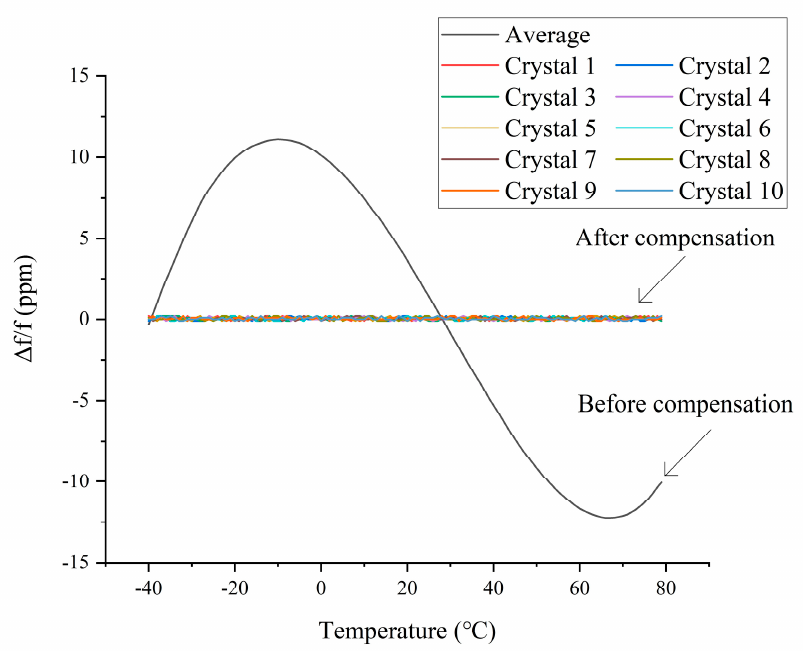
Figure 6. Comparison chart before and after compensation.